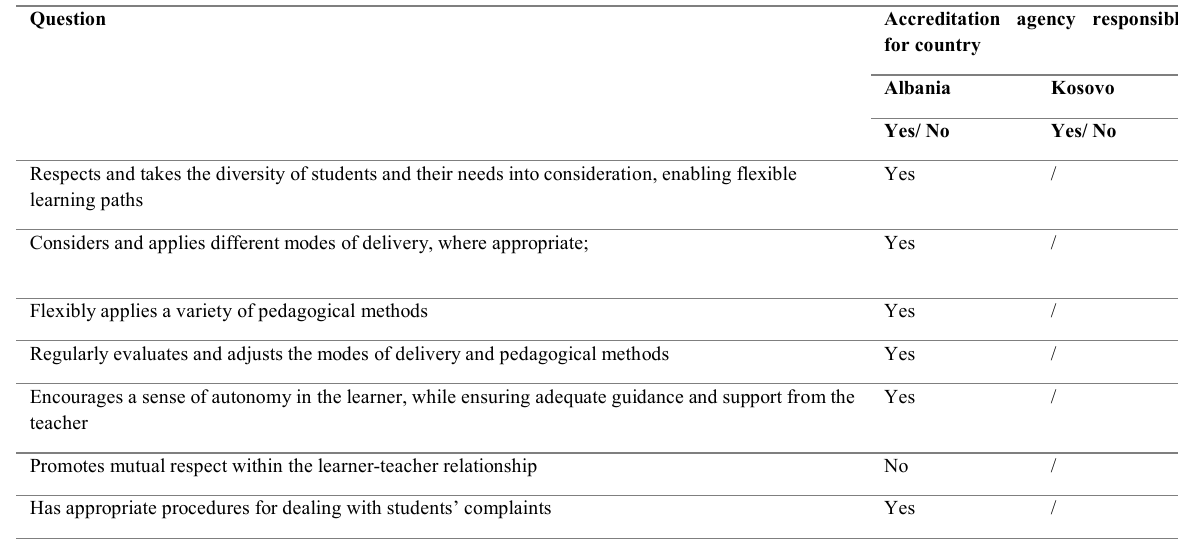
Table 13 : Internal quality assurance: Student-centered learning, teaching and assessment (KAA and QAAHE) Question